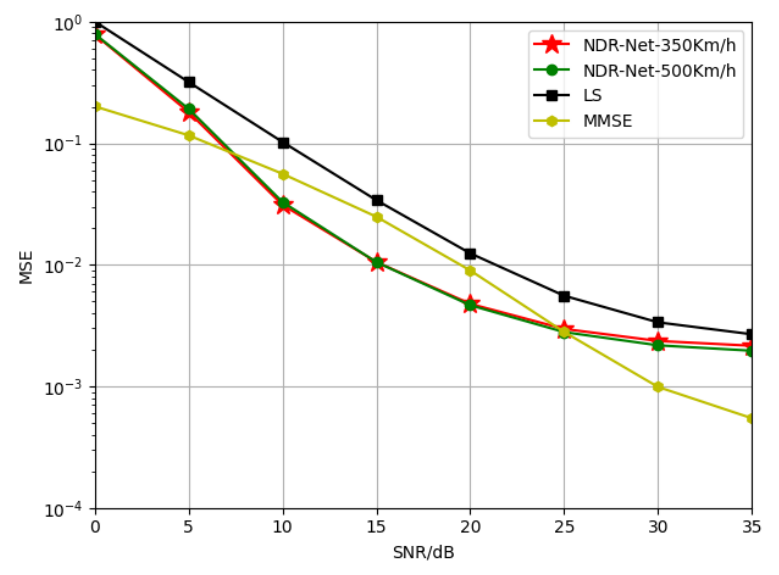
Figure 8. Generalization performance of NDR-Net when the training channels are TDL-C-350Km/h and TDL-C-500Km/h and the test channel is